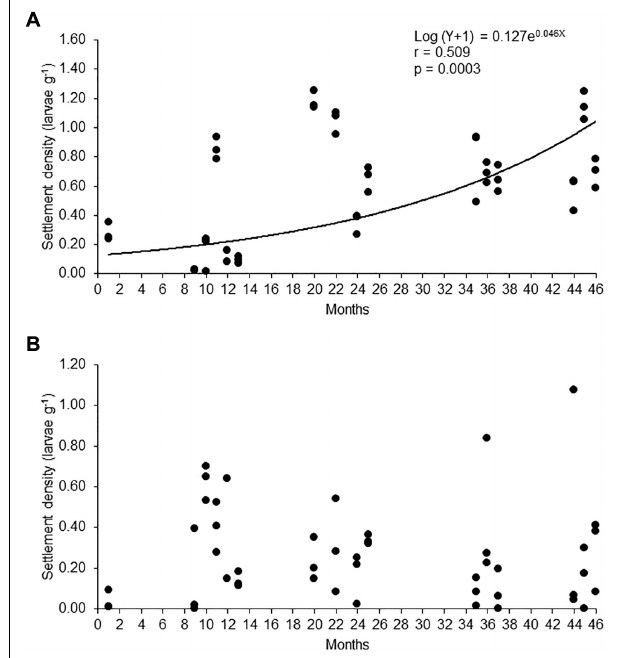
FIGURE 7 | Comparison of the relationship of the log-transformed settlement density (log X + 1) in (A) artificial collectors and (B) in Rhodymenia spp. during months of high larval abundance (November–April) through the study period. Statistics associated with model fitting are